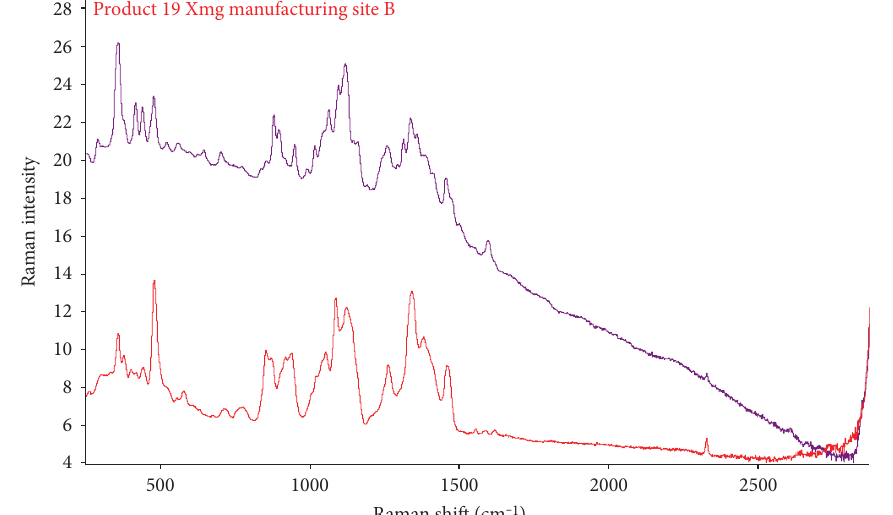
Figure 2: Raman spectra of two samples produced at di ff erent manufacturing sites and possessing the same dosage (product 19 Xmg). Due to di ff erences in the chosen formulation, the product presents heterogeneous spectra.